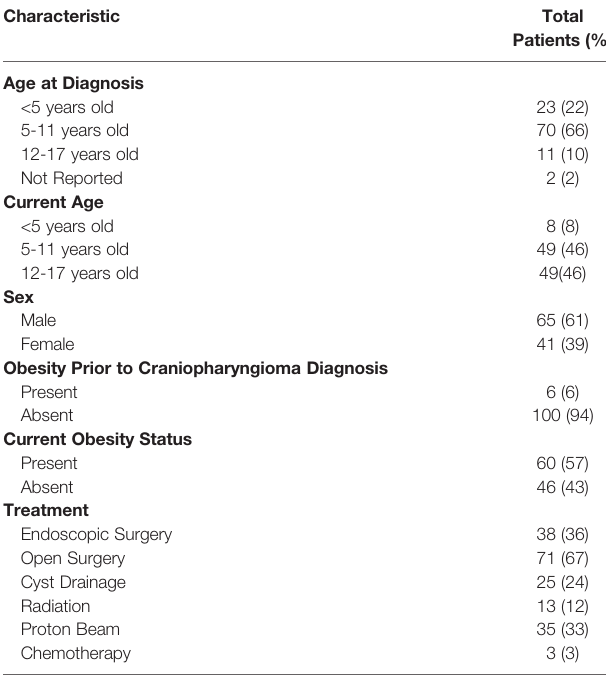
TABLE 1 | Patient demographics and clinical